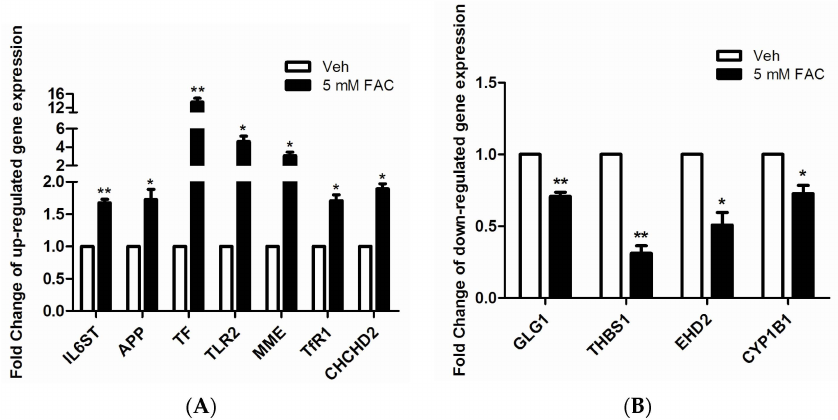
Figure 3. Confirmation of mass spectrometry-determined protein using RT-PCR technique. ( A ) Gene expression analysis of seven kinds of up-regulated proteins randomly selected from 93 kinds of differentially expressed proteins; ( B ) Gene expression analysis of four kinds of down-regulated proteins randomly selected from 93 kinds of differentially expressed proteins. The expression of genes was classified as up-regulated if expression levels were >1.5-fold and as down-regulated if levels were <0.67-fold, relative to control HH4 cells. Expression of β -actin was used as internal control. Results are shown as mean ˘ SEM of three independent experiments. Statistically significant differences are labeled as * p < 0.05 and ** p < 0.01, compared with the control groups, using unpaired Student’s t